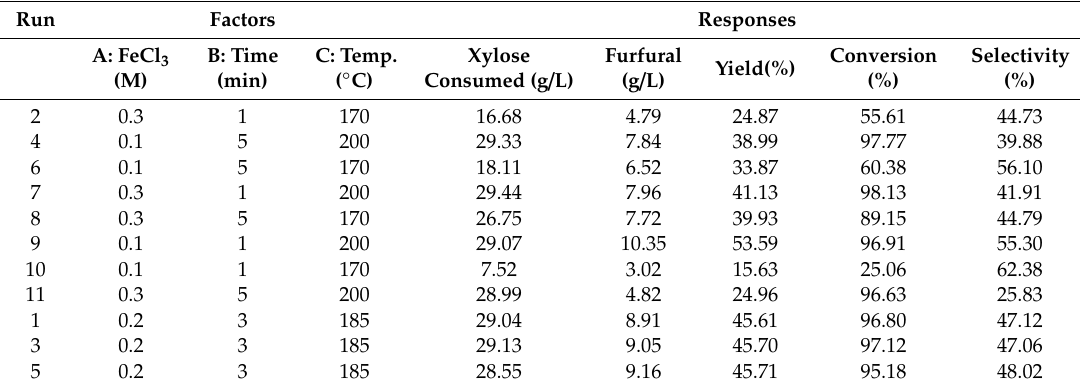
Table 1. Two-level, three-factor experimental design. Experimental conditions and response results.